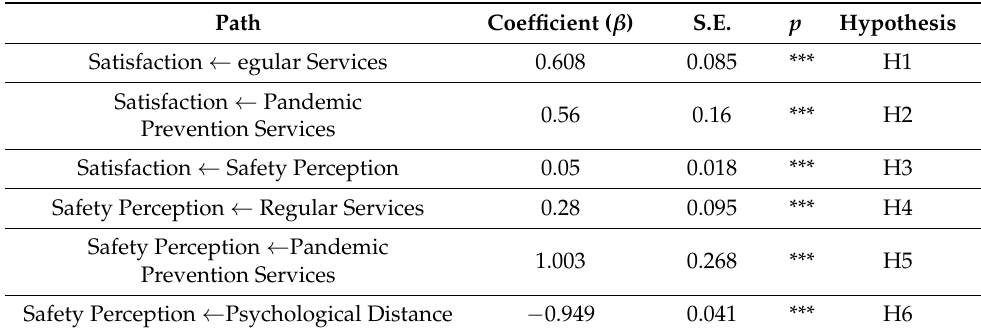
Table 4. Path coefficient and hypothesis verification results.